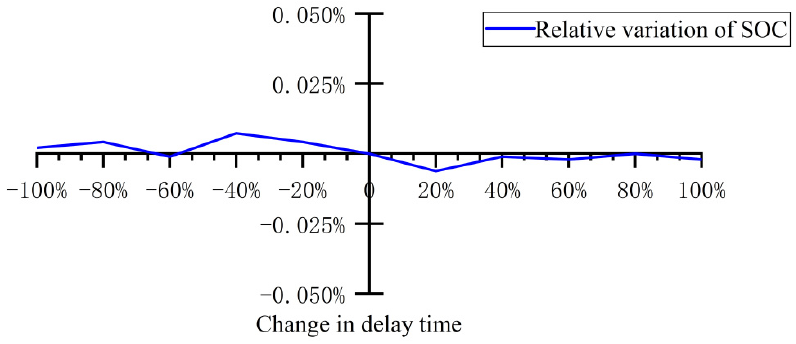
Figure 9. Sensitivity analysis of delay time values to SOC under road conditions.